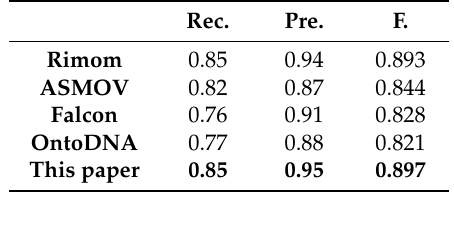
Table 9. Experimental comparison with other